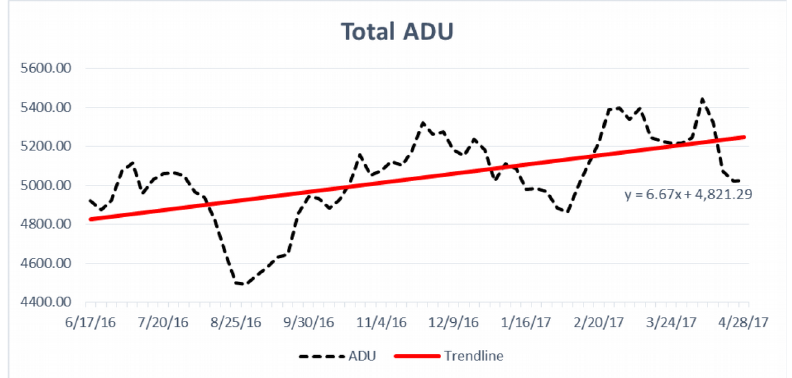
Figure 8. Evolution of the total ADU of 579 references belonging to the Goods cluster